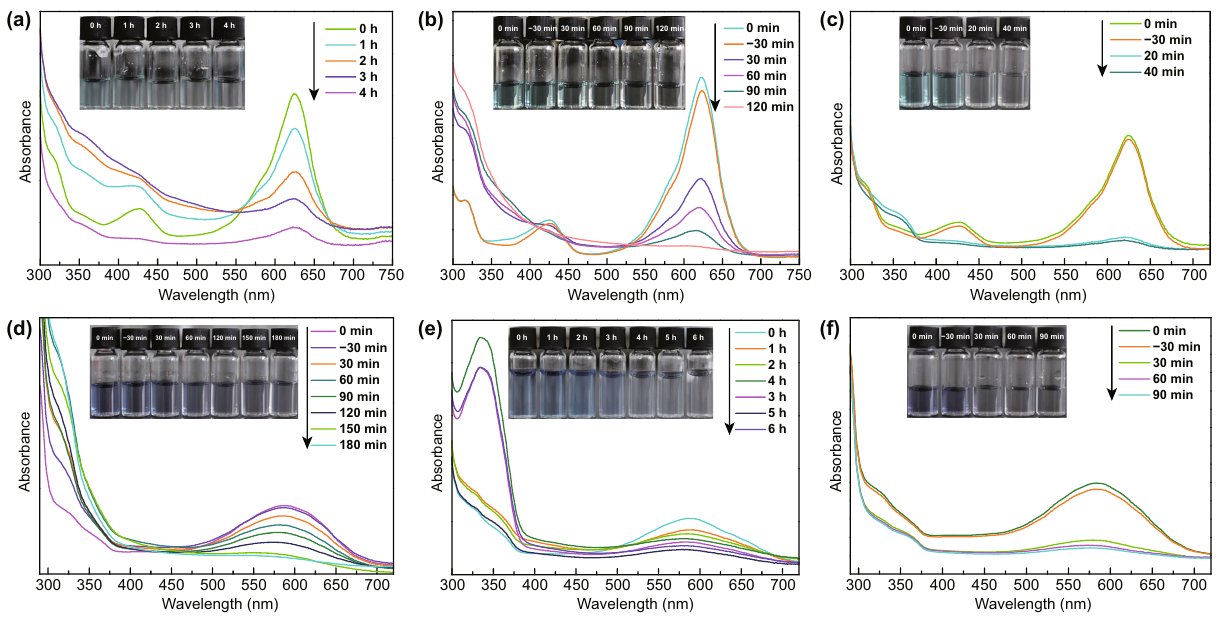
Fig. 4 Changes of the characteristic absorption after degradation by 3DGA@CDs-TNs photocatalyst, TENG, and TENG/3DGA@CDs-TNs of a–c BG and photographs of residual BG solution (inset); d–f DB and photographs of residual DB solution